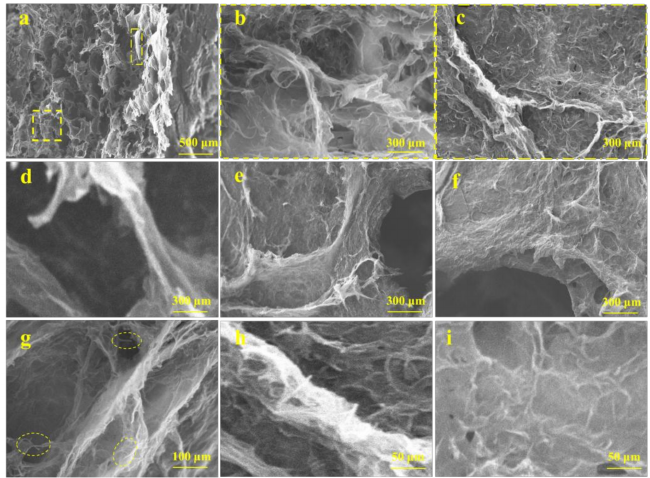
Figure 4. SEM image of the microstructure of graphene/CNTs aerogels; ( a–c ) SEM image of cross-section structure of graphene/CNTs aerogels under different magnification; ( d ) SEM image of the morphologies of curly graphene; ( e ) SEM image of the morphology of distorted graphene; ( f ) SEM image of the morphology of stacked graphene; ( g ) SEM image of the morphology of CNTs at different positions; ( h ) SEM image of the morphology of CNTs at the crosslinking point; ( i ) SEM image of the morphology of CNTs on the surface of